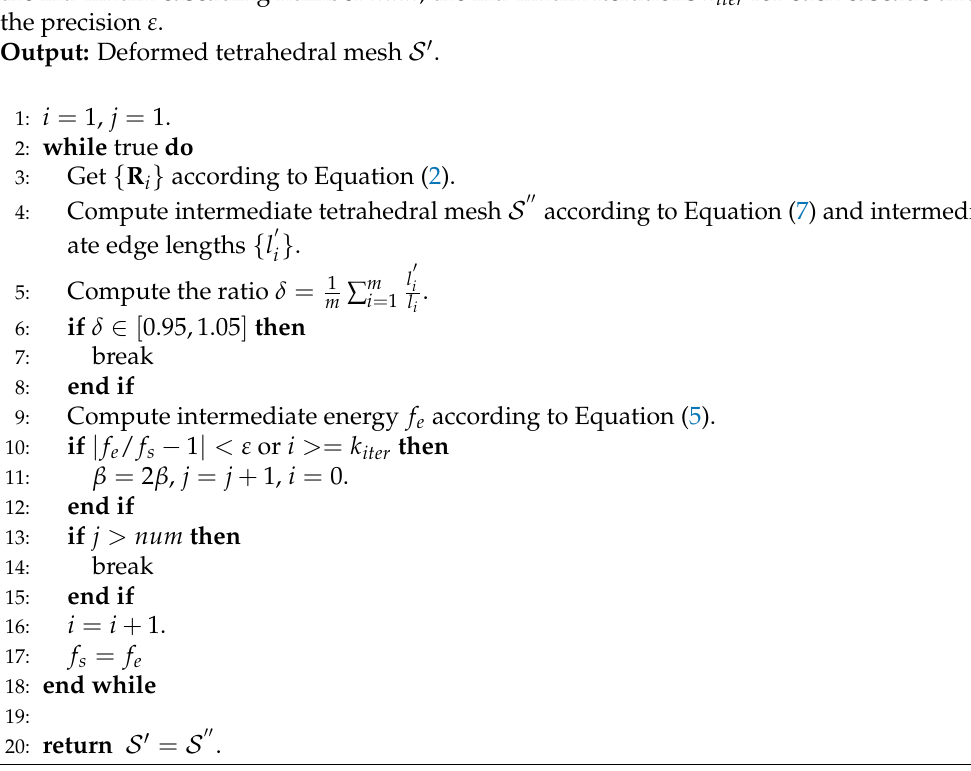
Algorithm 1 Shape unfolding cascading